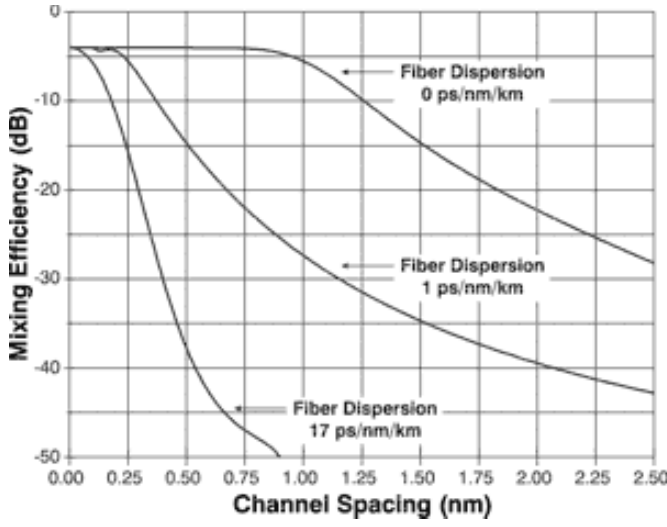
Figure 2. Variation in mixing efficiency with wavelength spacing